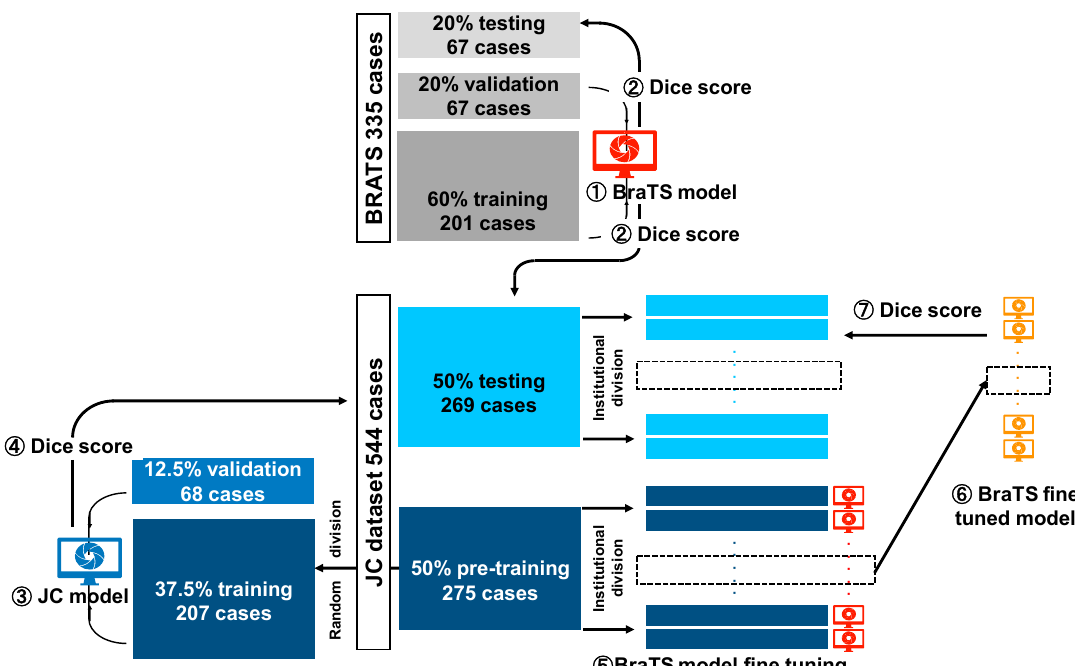
Figure 1. The overall flow of this research. Three types of machine learning models were built for segmentation: The Multimodal Brain Tumor Image Segmentation Benchmark (BraTS) model, the Japanese cohort (JC) model, and the fine- tuning model. (1) The BraTS model was trained in the training part of the BraTS dataset. (2) The BraTS model was evaluated by the Dice coefficient scores of the BraTS data set and the test portion of the JC data set. (3) The JC model was trained on the training portion of the JC data set. (4) The JC model was evaluated by the Dice coefficient score of the test portion of the JC data set. (5) The BraTS model was fine-tuned for optimal analysis at each facility. (6) The BraTS model fine-tuned by the aforementioned method, was named the fine-tuning model. (7) The fine-tuning model was evaluated with the Dice coefficient score of the test portion of the JC data